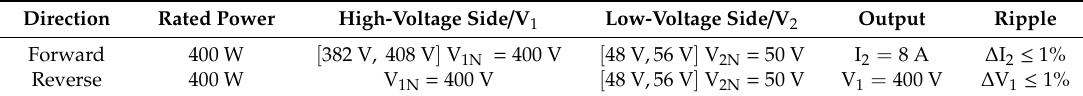
Table 2. Design requirements of the